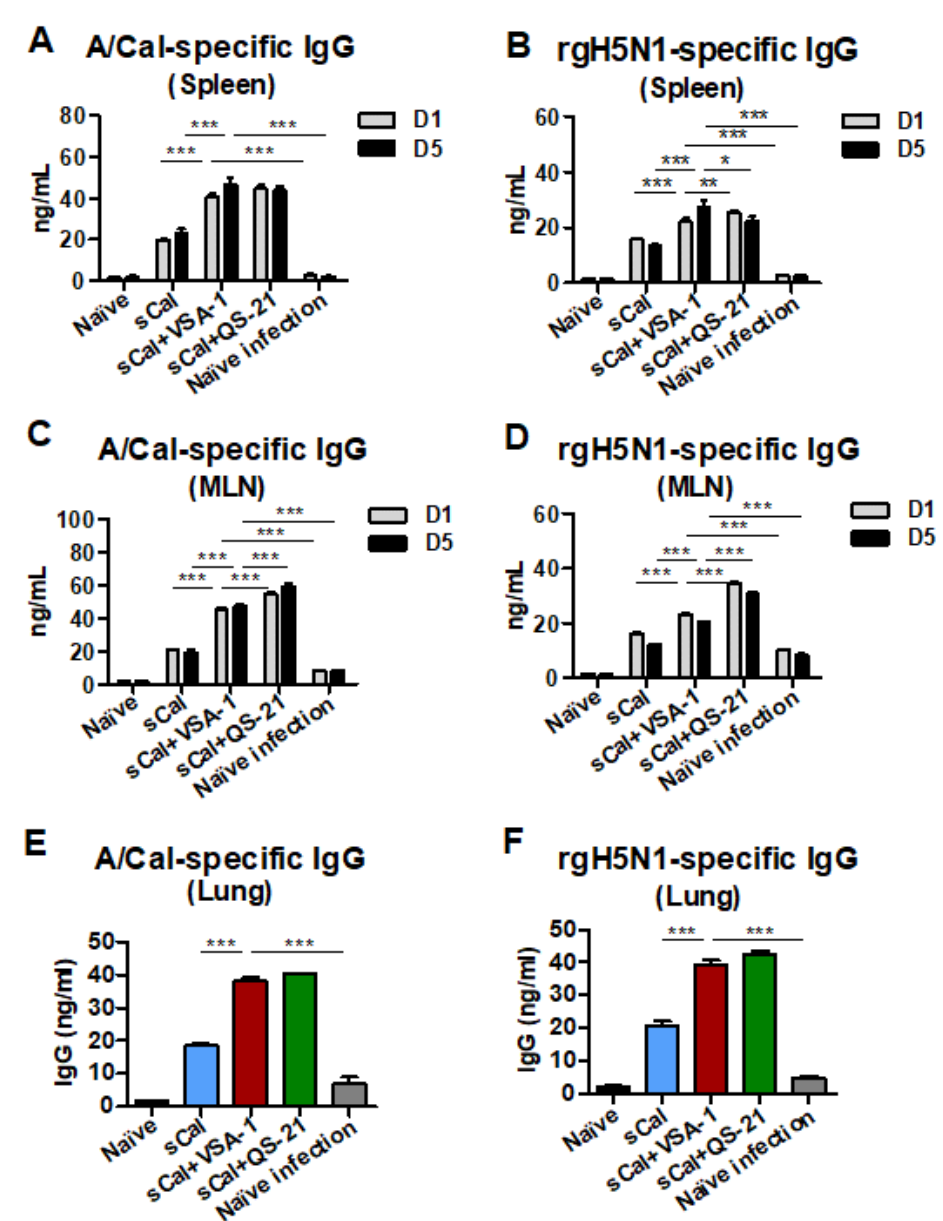
Figure 8. VSA-1-adjuvanted sCal vaccination enhances antibody-secreting cell responses. ( A – D ) A/Cal virus-specific and rgH5N1 virus-specific IgG (in vitro) production from ( A , B ) splenocytes